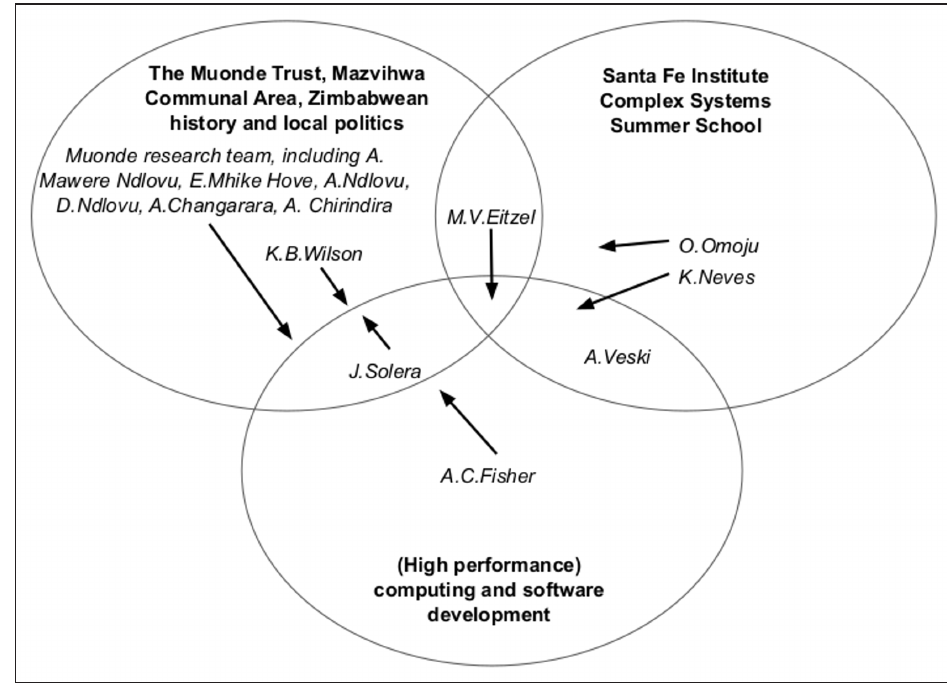
Figure 2 The movement through different contexts of participants in the modeling process. In bold text are the three primary contexts of our process (computing, complex systems, and the study system/community-based research; represented by the three circles), and in italic text are the authors and participants. Many participants began with a focus in one of these contexts and then shifted toward one or more of the other contexts during the process (diagrammed using arrows from starting location to ending location); in particular, the first author ultimately sat at the intersection of the modeling, agro-ecosystem, and complex systems science context, as Étienne et al. indicate is necessary for a participatory modeling facilitator